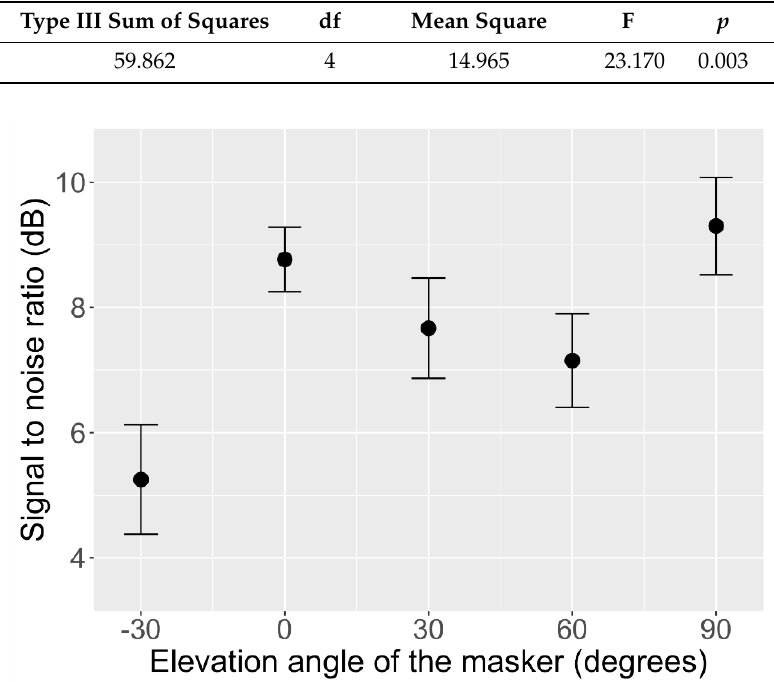
Table 1. Results of repeated measure ANOVA (the sphericity is assumed based on Mauchly’s test of sphericity ( p = 0.542)).